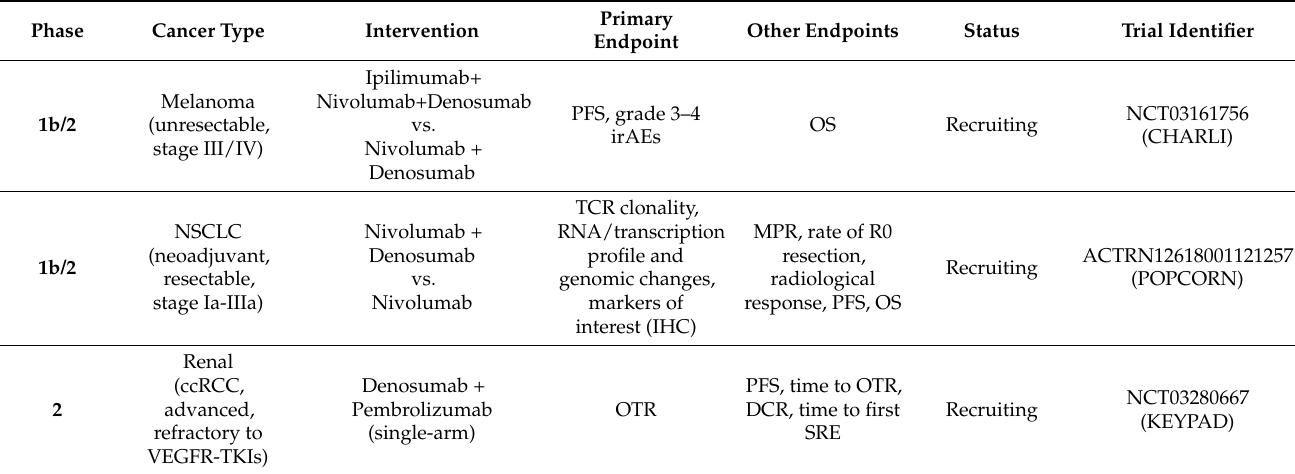
Table 4. Clinical trials investigating the immunomodulatory properties of denosumab in combination with immune checkpoint inhibitors in human